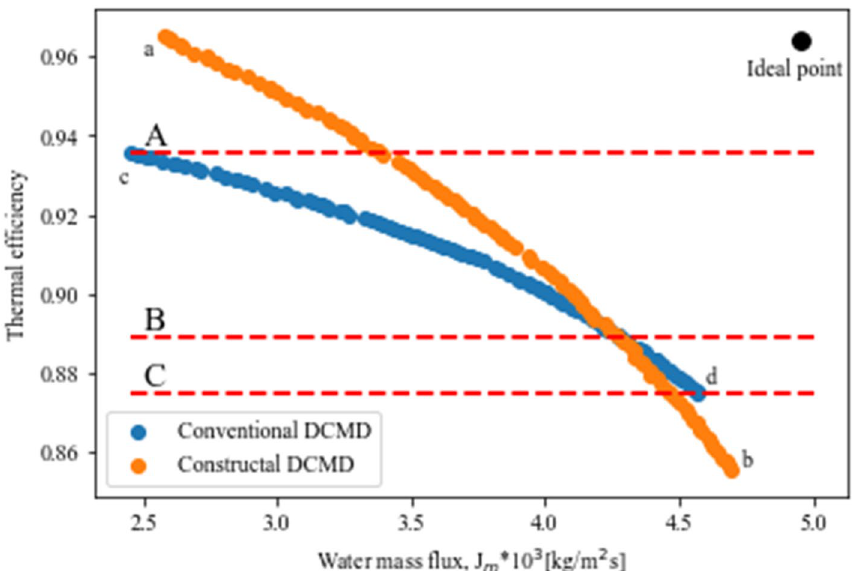
Figure 5. Pareto frontiers for conventional and constructal DCMD